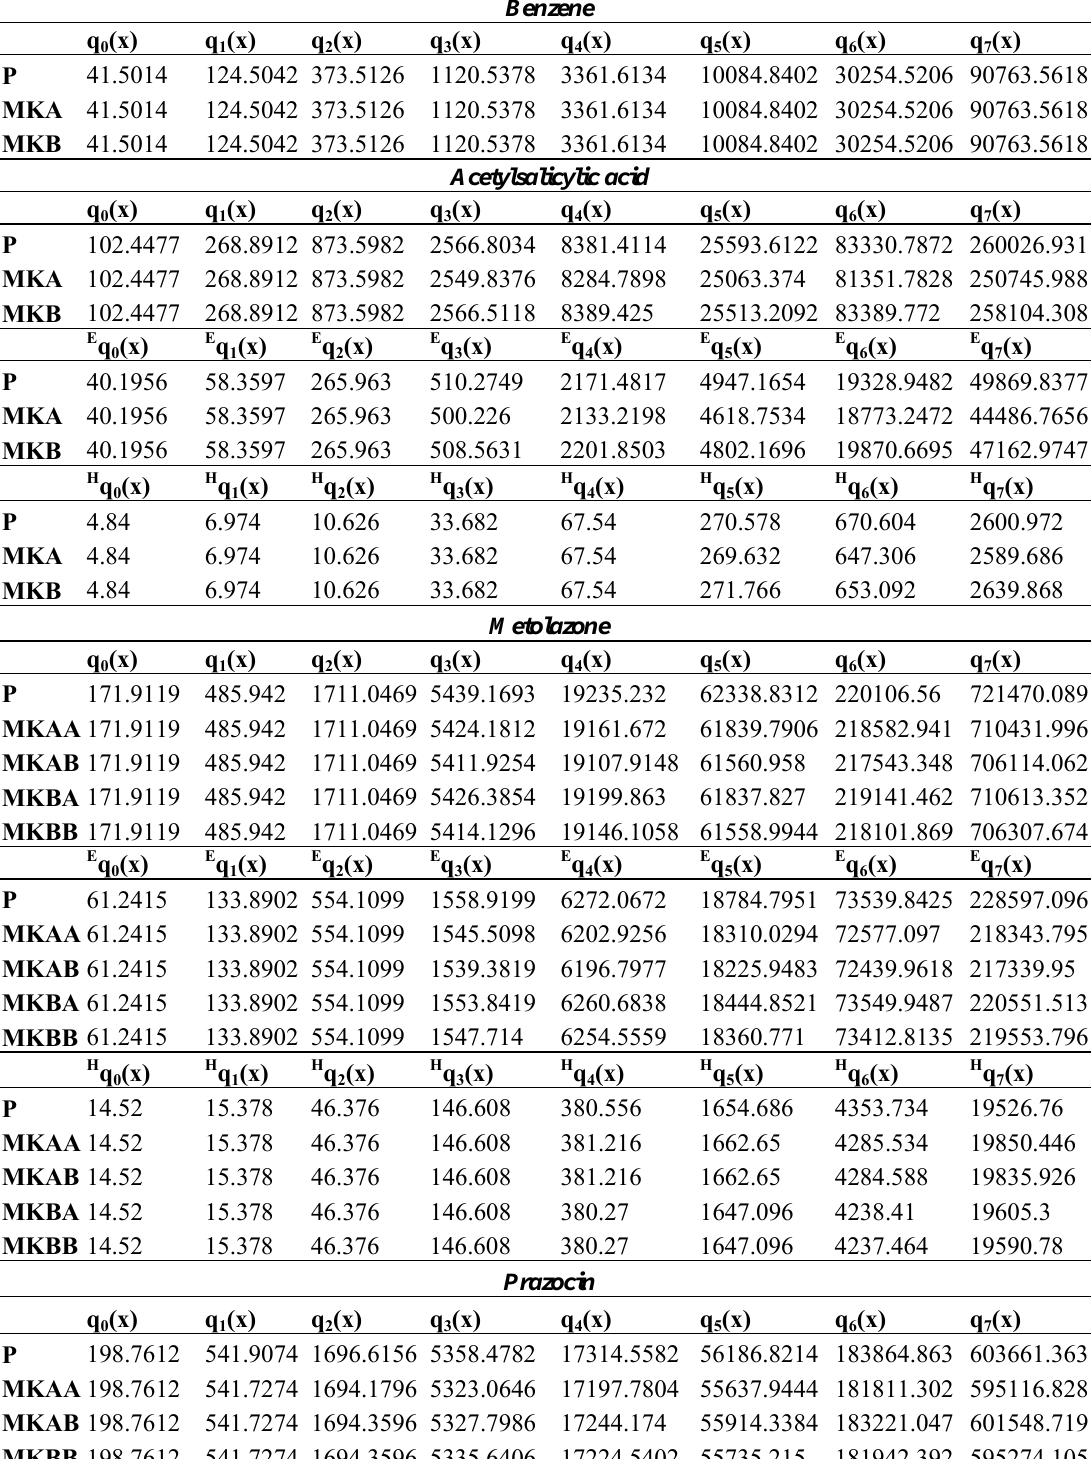
Table 1. Total and Local Quadratic Indices Calculated for Multigraphs (MKA, MKB) and Pseudographs